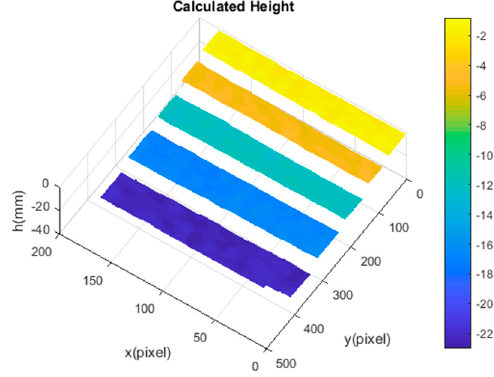
Figure 8. 3D shape data of the artificial mirror step. Table 2. Experimental results of the mirror step (units: mm).